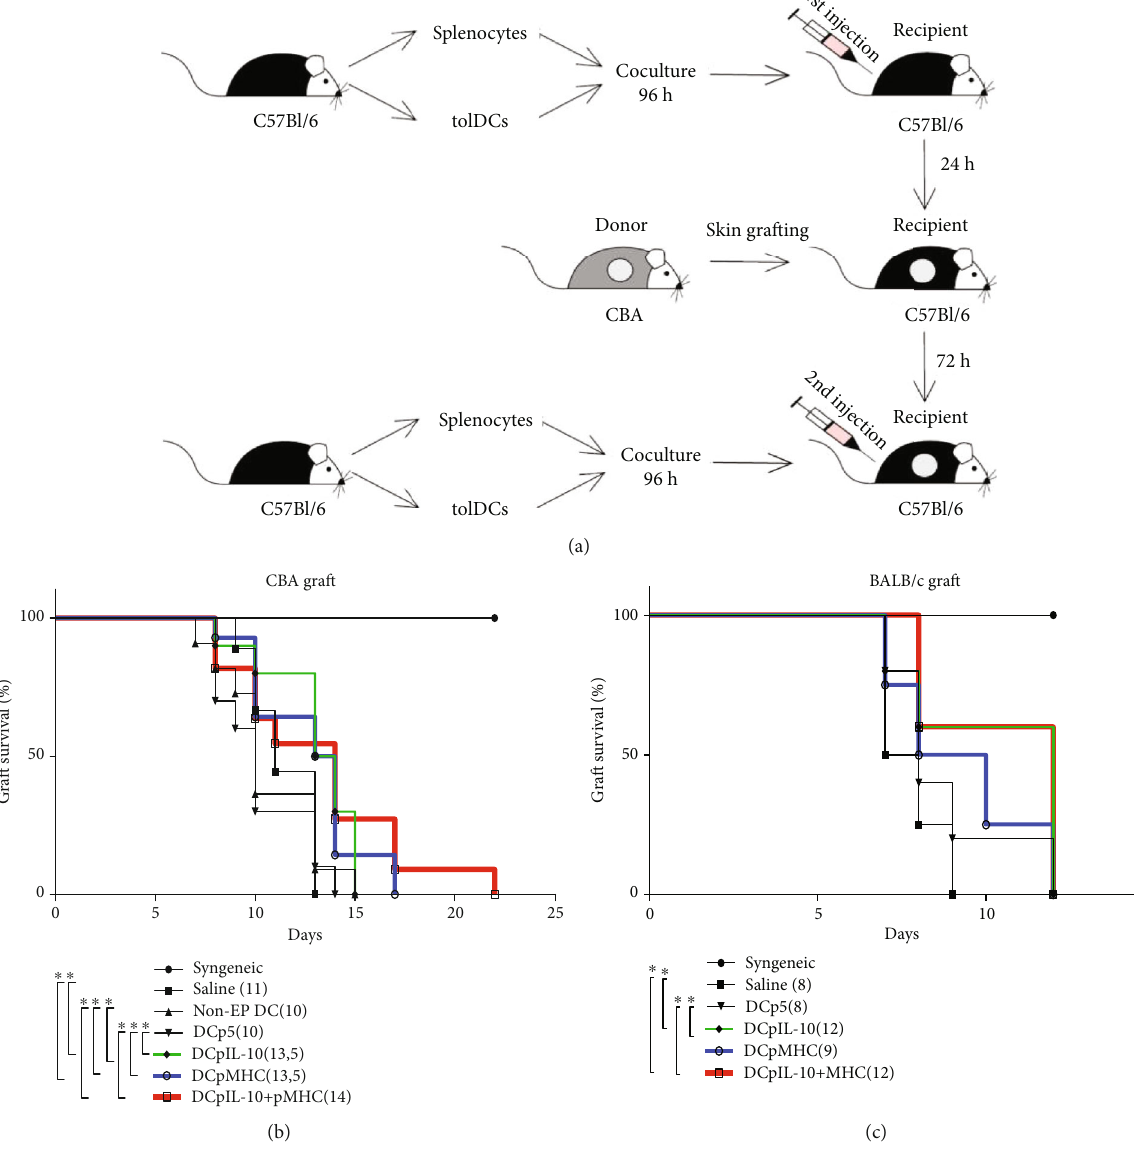
Figure 7: Suppression of allogeneic skin graft rejection by splenocytes cocultured with transfected DCs. Experimental design (a) and survival curves for (b) CBA and (c) BALB/c skin grafts. (b) N = 10 . (c) N = 4 . The median graft survival time has indicated in round brackets for each group, where applicable. Square brackets indicate signi fi cant di ff erences (the Mantel-Cox test and log-rank test for trend, ∗ P < 0 : 05 ). Syngeneic: transplantation of syngeneic skin graft without other interventions (positive control); Saline: administration of saline; non-EP DC: administration of nonelectroporated DCs; DCp5: administration of cocultures of autosplenocytes and DCs electroporated with